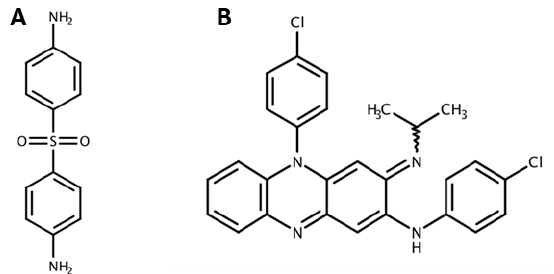
Figure 4. Chemical structures of ( A ) dapsone and ( B ) clofazimine.